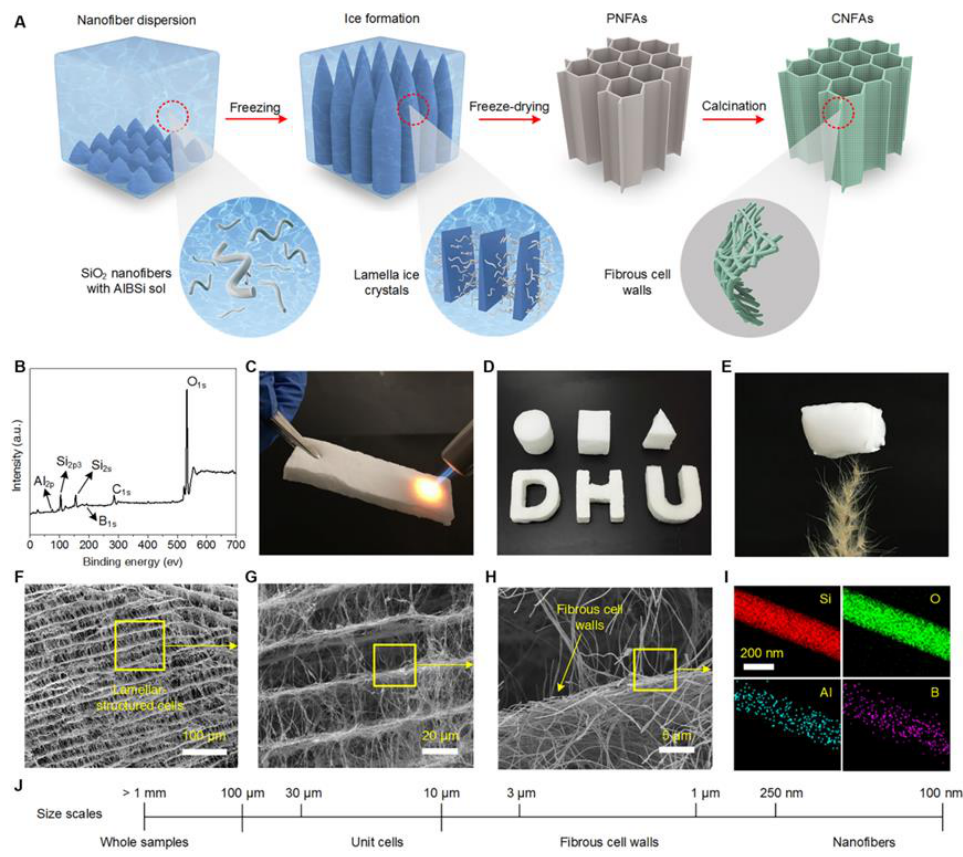
Figure 6. Fabrication process of SiO 2 nanofiber aerogel (CNFAs) ( A ) Schematic illustration of the fabrication of CNFAs. ( B ) XPS spectrum of CNFAs for all elements; a.u., arbitrary unit. ( C ) A CNFA heated by a butane blowtorch without any damage. ( D ) An optical image of CNFAs with diverse shapes. ( E ) An optical image showing a 20 cm 3 CNFA (r = 0.15 mg·cm − 3 ) standing on the tip of a feather. ( F – H ) The microscopic structure of CNFAs at different magnifications demonstrates the hierarchical nanofibrous cellular architecture. ( I ) STEM-EDS images of a single nanofiber with corresponding elemental mapping images of Si, O, Al, and B, respectively. ( J ) Schematic showing the three levels of a hierarchy of the relevant structures. (Reprinted with permission from Ref. [5]).